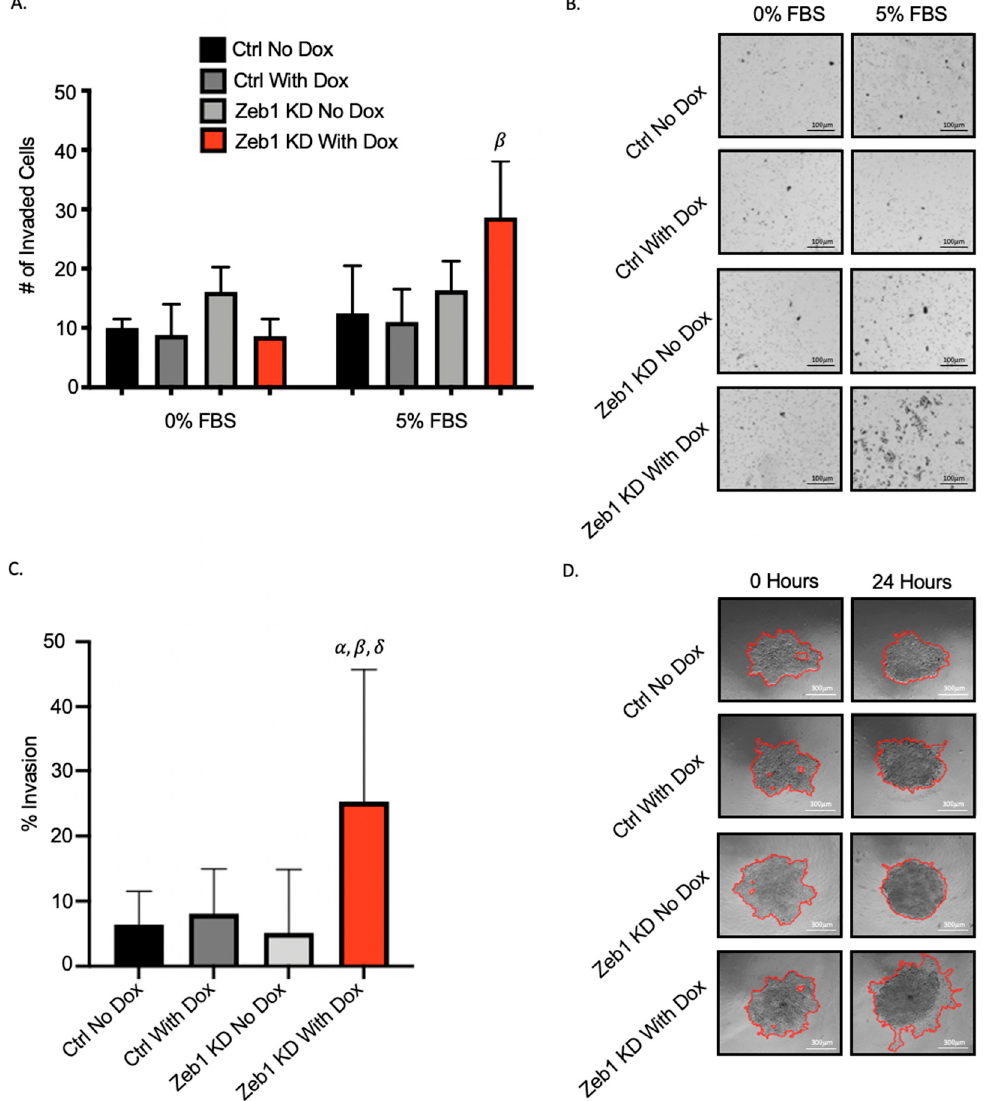
Figure 3. Knockdown of Zeb1 in PC-3 prostate cancer cells increases cell invasion. ( A , B ) Transwells were coated with 4 µg/well of Matrigel. Cells (5 × 10 4 /well) were added to wells and either control media (0% fetal bovine serum [FBS]) or chemoattractant media (5% FBS) was added and cells were allowed to invade for 24 h. Cells were fixed with 1% glutaraldehyde and mounted with DAPI-containing mounting media. ( C , D ) For spheroid invasion assays, cells were seeded onto ultra-low attachment plates and allowed to grow for 96 h to create spheroids. Matrigel was then added and invasion was quantified after 48 h. Representative images are shown for each assay; with invasion calculated based on 5 high-powered fields of view (HP-FOV) per well. Black scale bars = 100 µm, white scale bars = 300 µm. Data is presented as the mean ± standard error of the mean (SEM) ( n = 3). α = significantly different than PC-3 control (ctrl) no doxycycline (Dox). β = significantly different than ctrl with Dox. δ = significantly different than Zeb1 KD ( Zeb1 knockdown) no Dox ( p ≤ 0.05).